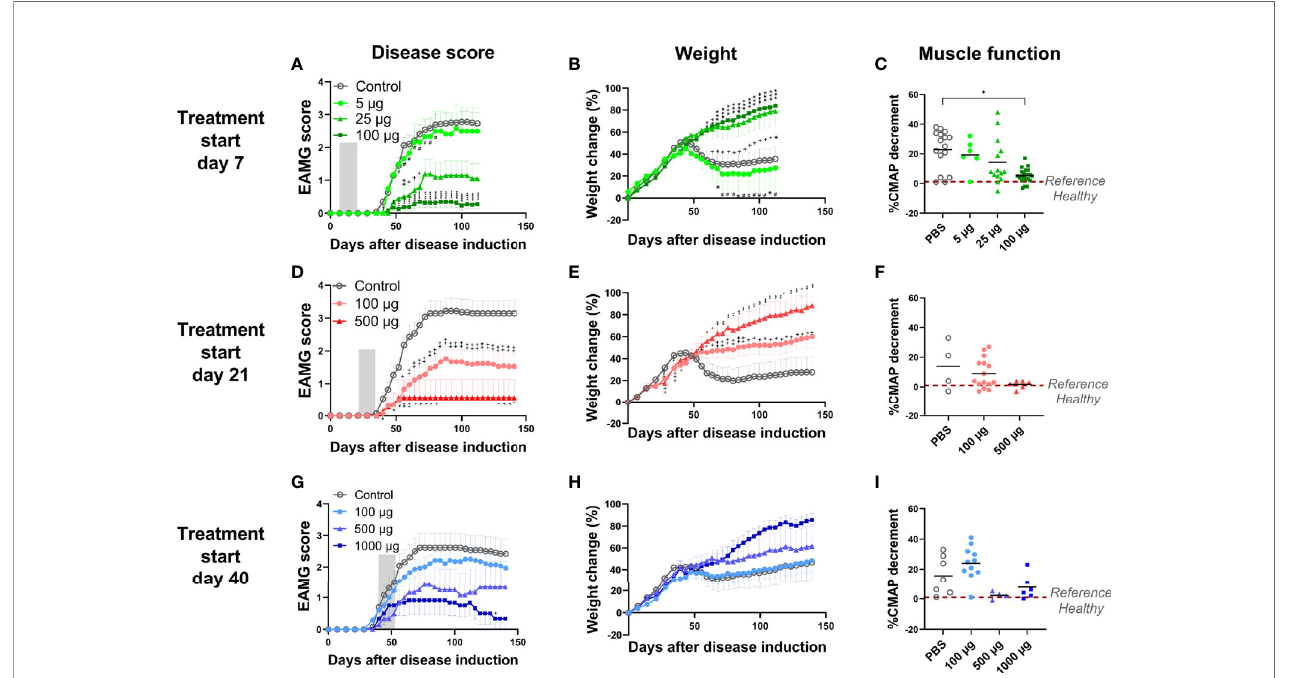
FIGURE 2 | Intravenous administration of a 1-ECD mt abrogates EAMG development in a dose and time dependent manner. (A-C) The data are compiled from 3 independent experiments. Rats were treated starting on day 7 with 5 m g (N = 6, circles), 25 m g (N = 14, triangles), 100 m g a 1-ECD mt (N = 23, squares) or PBS (N = 23, open circles). (D-F) The data are compiled from 2 independent experiments. Rats were treated starting on day 21 with 100 m g (N = 21, circles), 500 m g a 1- ECD mt (N = 7, triangles) or PBS (N = 14, open circles). (G-I) The data are compiled from 2 independent experiments. Rats were treated starting on day 40 with 100 m g (N = 14, circles), 500 m g (N = 6, triangles), 1000 m g a 1-ECD mt (N = 6, squares) or PBS (N = 13, open circles). Grey bars, ( in A, D, G ) indicate the treatment period. The EAMG score (average ± SEM), percentage of body weight change (average ± SEM), and CMAP decrement were measured (for the later each symbol corresponds to one rat and the bar shows the mean value). In (A-C) # compares 5 µg vs 100 µg, + compares PBS vs 25 µg, and * compares PBS vs 100 µg. In (D – F) + compares PBS vs 100 µg and *compares PBS vs 500 µg. In (G-I) * compares PBS vs 1000 µg.